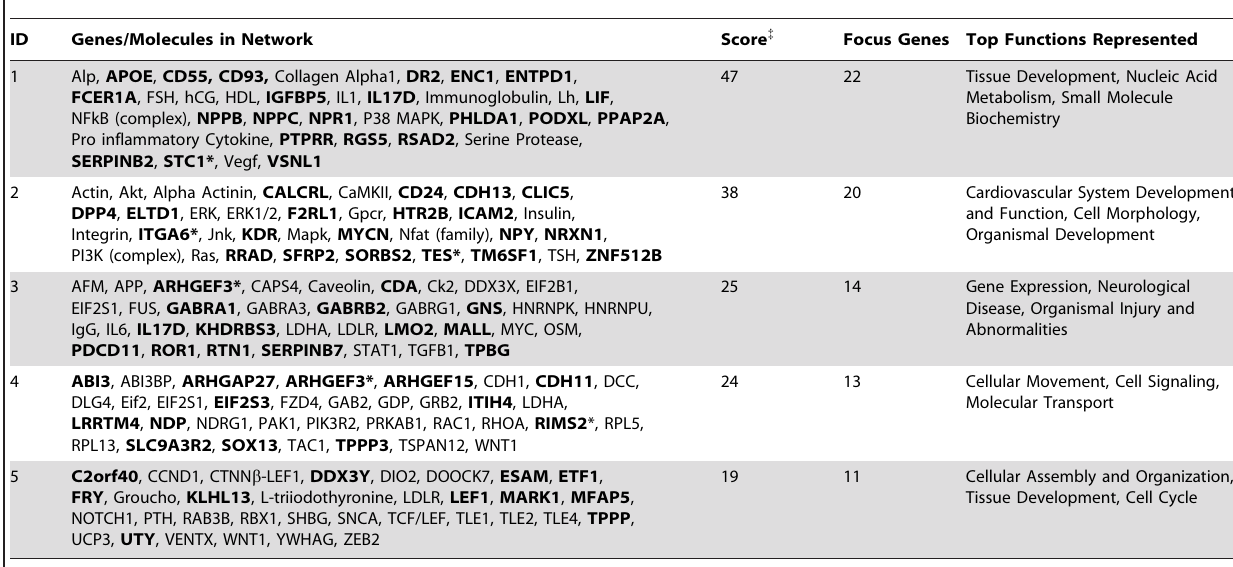
Table 2. IPA-generated molecular networks assembled from differentially expressed genes (bold) in males versus females in the significant genes